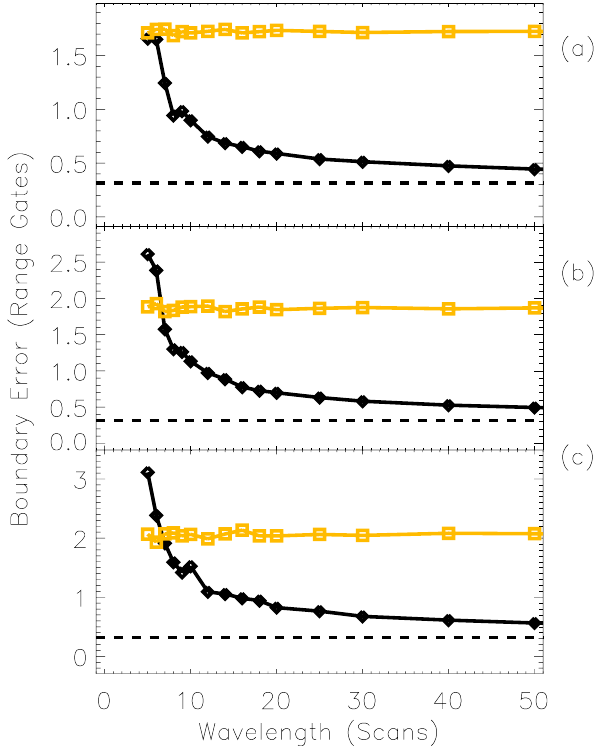
Fig. 11. The variation of the percentage of correct boundaries iden- tified by algorithm 2 (solid orange line) and algorithm 3 (solid black line), with a threshold of 150 m/s, when applied to a simulated data set with a variable sinusoidal boundary. The variations are presented for a range of boundary wavelengths and for sinusoidal amplitudes of (a) 2, (b) 3, and (c) 4 range gates. The black dashed line presents the value measured by algorithm 3 when no boundary variation is present (as in Fig. 8).